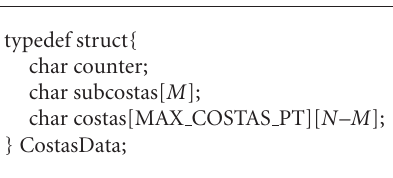
Algorithm 2: The array of K permutations used between the Host and GPU is an array of size K of type CostasData counter stores the number of Costas array of size N found in each thread of the GPU, subcostas stores one of the subpermutations of size M computed in the Host, and costas stores a maximum number of the remaining ( N – M ) elements of the Costas arrays of size N found in each thread of the